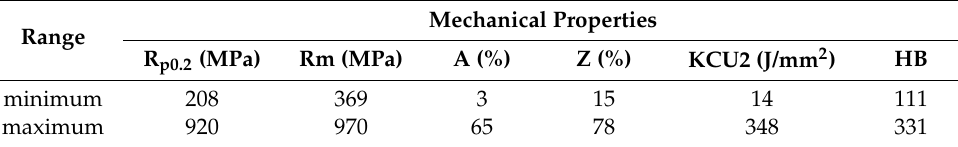
Table 1. The range of selected input variable values.